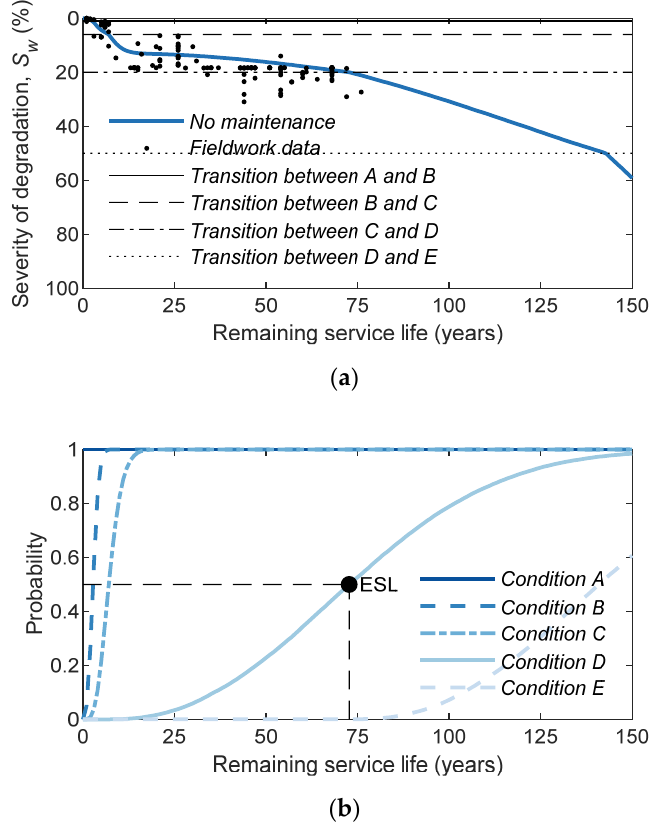
Figure 2. Degradation process of the ceramic claddings in pitched roofs (CCPR) without the impact of maintenance activities: ( a ) mean degradation profile overlapped by the fieldwork data and ( b ) cumulative distribution functions.